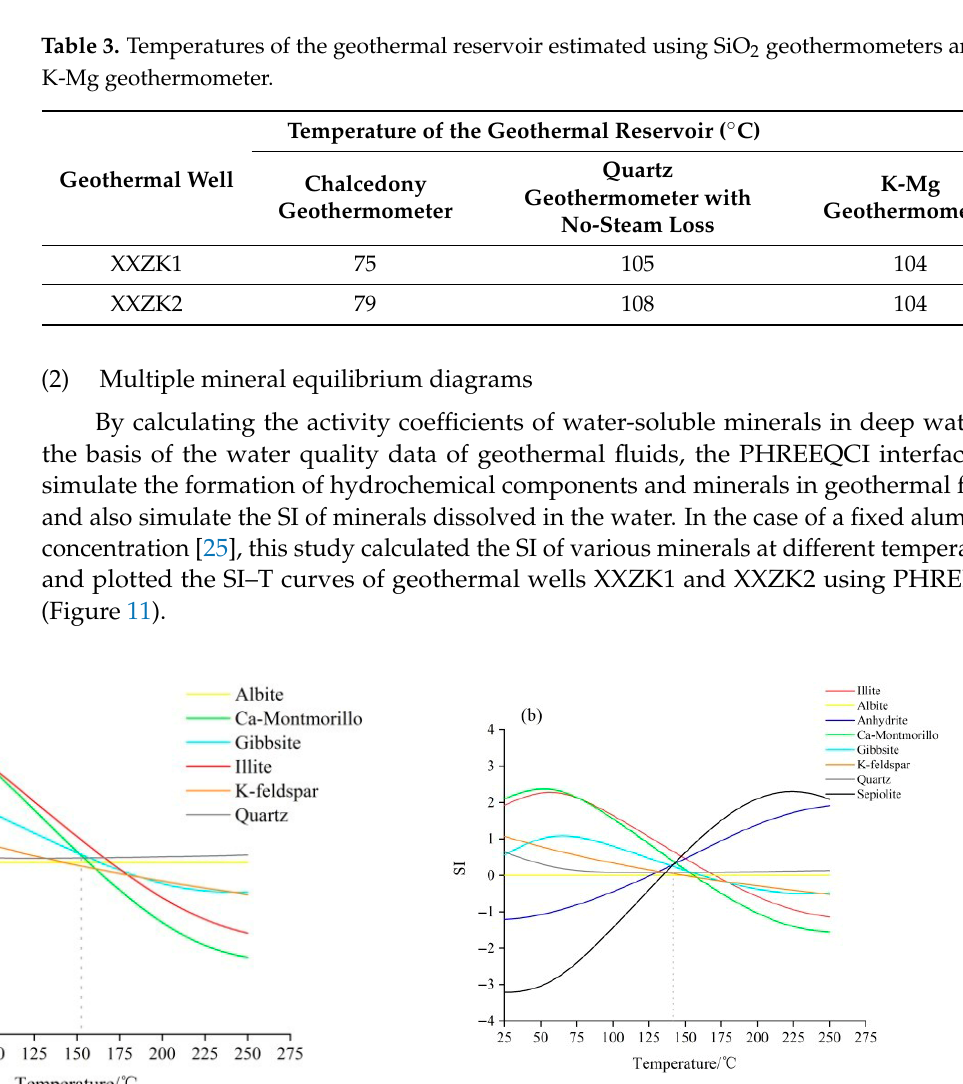
Figure 11. SI–T curves of various minerals from geothermal wells XXZK1 and XXZK2 in the Xianxian geothermal field: ( a ) XXZK1, ( b ) XXZK2.